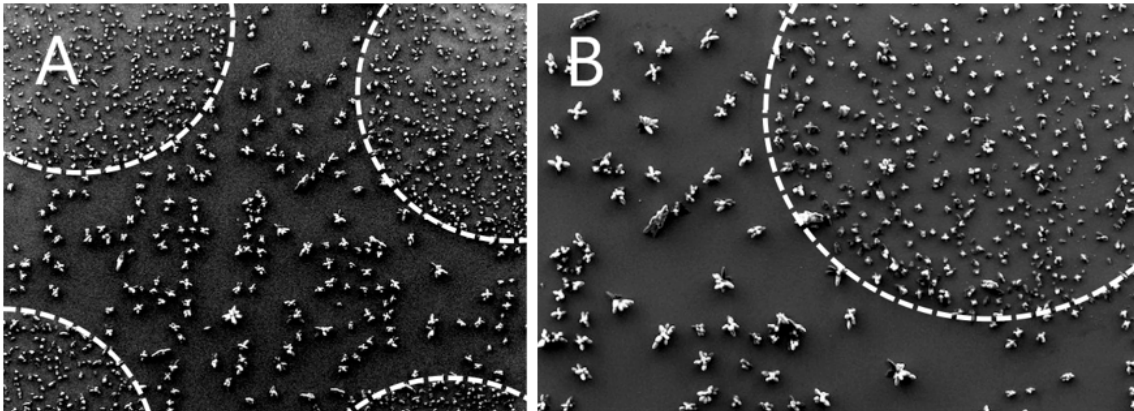
Figure 2. Scanning electron microscopy (SEM) images of CHCA crystals. Image ( B ) is a detail of the upper right corner of the left image ( A ). Pictures allow for direct comparison of matrix crystallization on areas having nanoscale surface roughness (dashed areas) and on surrounding flat surface.